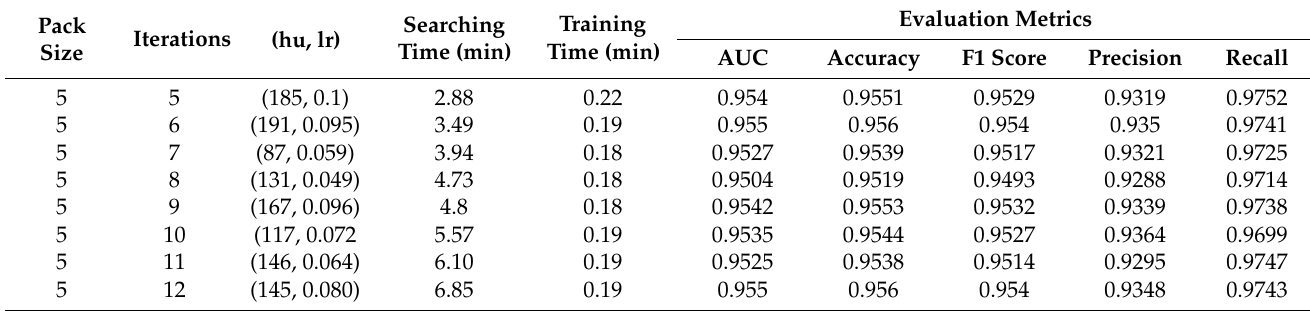
Table 5. Hu and lr obtained under different iterations and the experimental